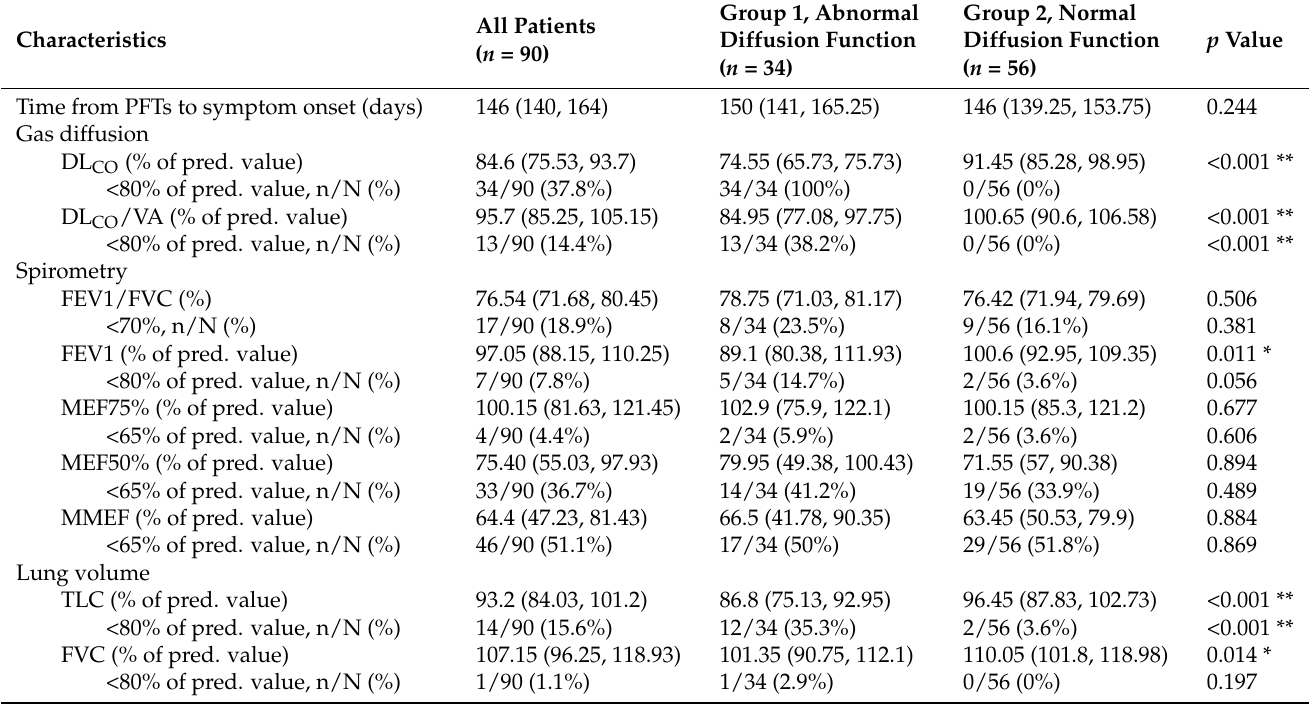
Table 3. Pulmonary function tests of convalescent COVID-19 patients 5 months after symptom